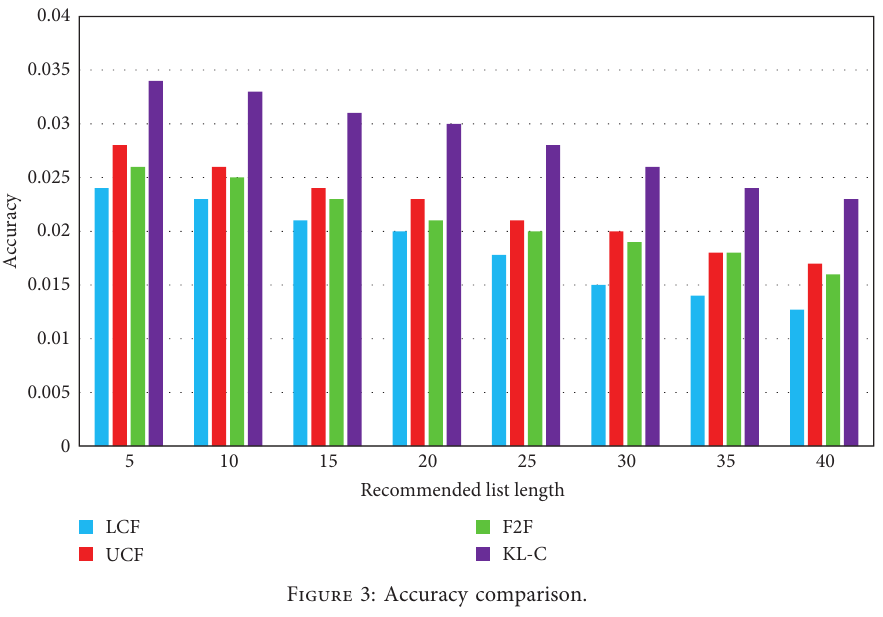
Figure 3: Accuracy comparison.